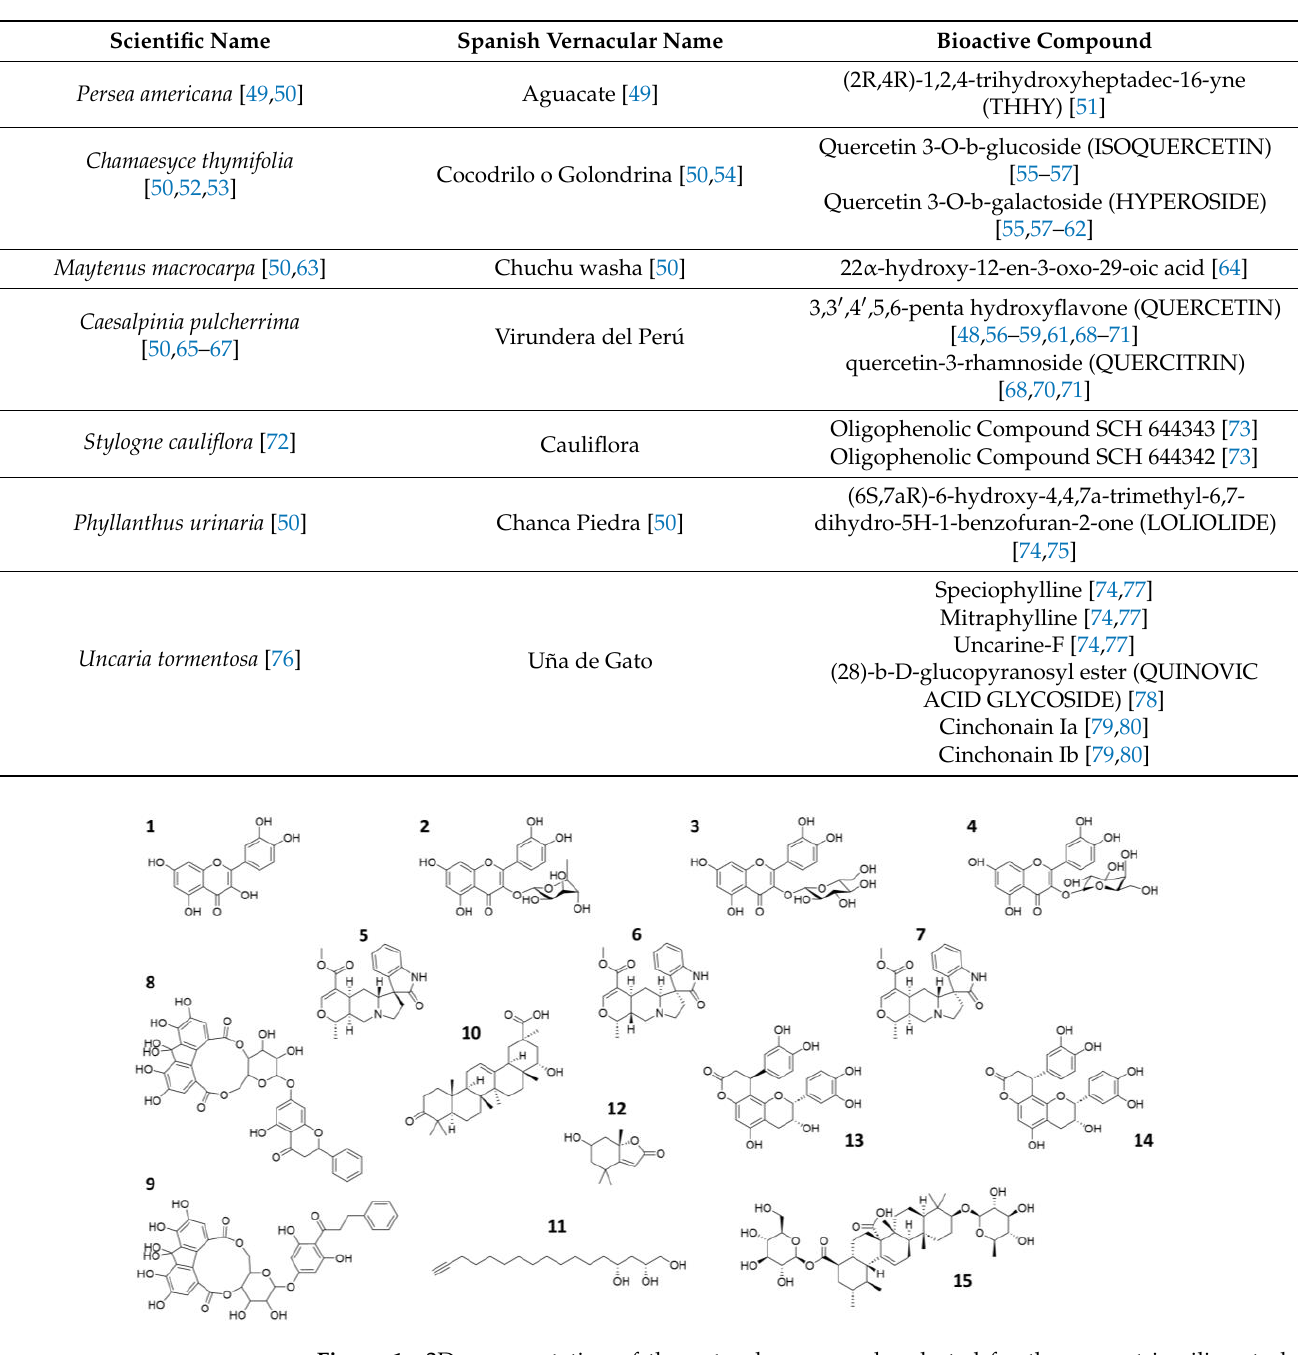
Table 1. Bioactive compounds present in the Peruvian flora selected from the literature for the in-silico study. References for each of the selected compounds are indicated.